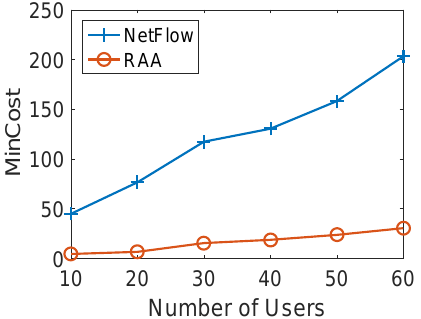
Figure 8. Mincost for varied numbers of users with 20 APs.